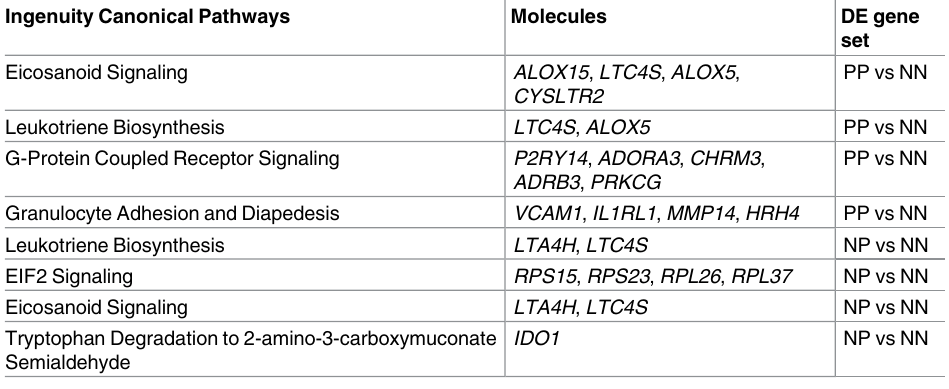
Table 6. Top canonical pathways associated with DE genes in PP vs NN and NP vs NN